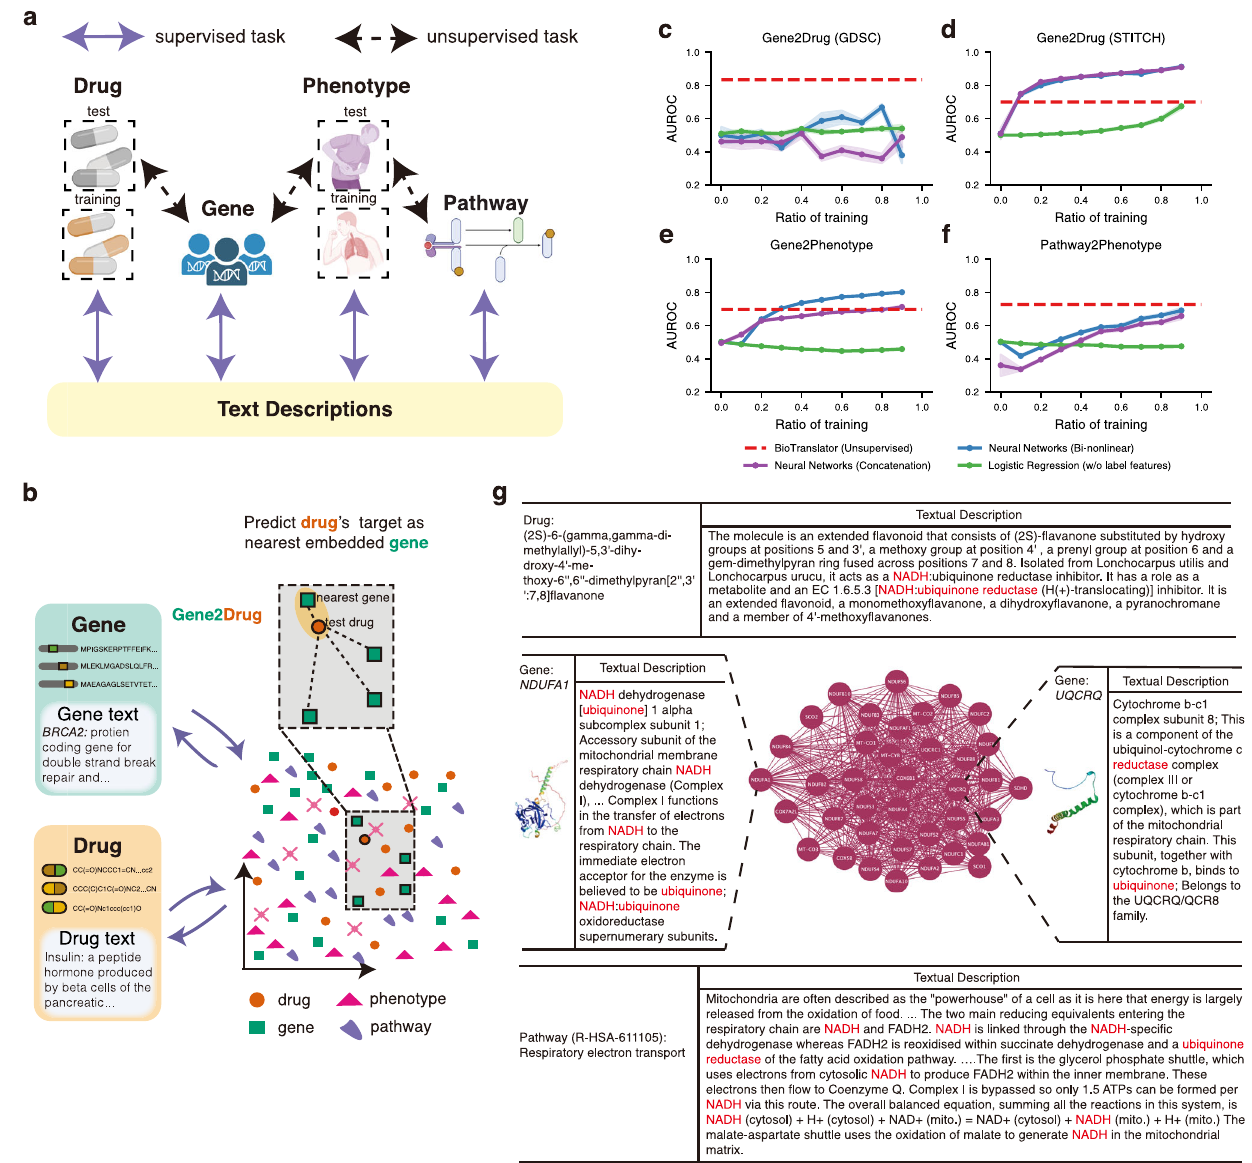
Fig. 4 | Performance of BioTranslator on prediction without paired data. a Diagram of BioTranslator ’ s multilingual translation framework. During the trainingstage,drugs,genes,phenotypesandpathwaysweretranslatedintothetext embedding space. BioTranslator then enables drug-target interaction prediction, phenotype-gene association prediction, and phenotype-pathway association pre- diction using this co-embedding space without access to the paired data between two non-text modalities. Created with BioRender.com. b Flowchart showing how BioTranslator predicts association between different modalities. The target of a given drug is predicted as its nearest gene in the embedding space. BioTranslator doesnotneedtousethetextualdescriptionoftestdrugsandphenotypes,butonly needs theirbiologicalfeatures(e.g., SMILESfordrugs,humanphenotypeontology for phenotypes). c – f cross-modal translation between drug and gene on GDSC ( c ), drugandgeneonSTITCH( d ),geneandphenotype( e ),andpathwayandphenotype